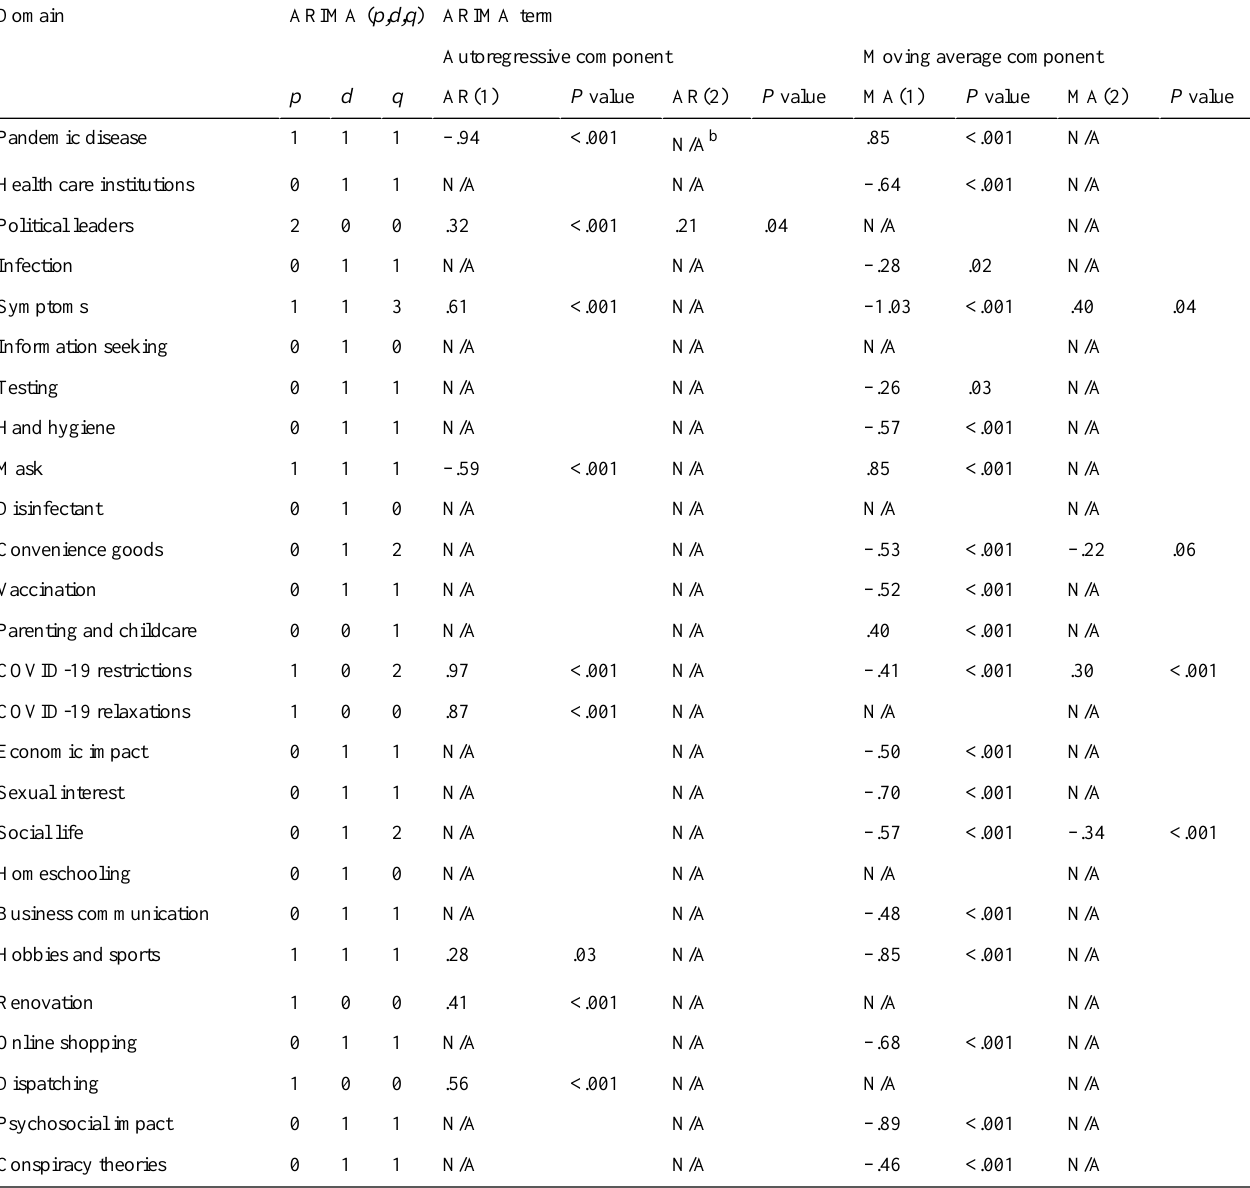
Table 4. ARIMA regression results for the ARIMA model part with standardized betas for the autoregressive and moving average components a .